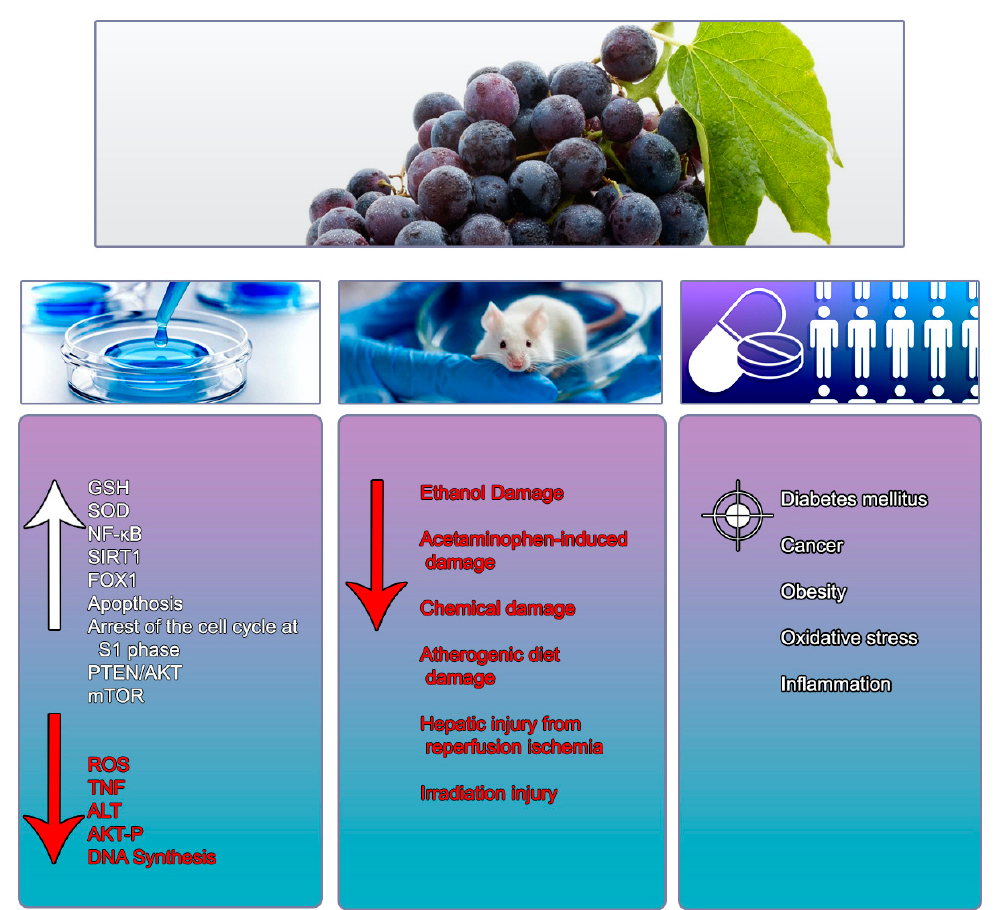
Figure 1. Summary of the main molecular mechanisms and physiological effects exerted by Resveratrol in vitro, in vivo and clinical studies. Red arrow ( ↓ ) indicates down-regulation; white arrow ( ↑ ) indicates up-regulation. GSH: glutathione; SOD: superoxide dismutase; NF- κ B: nuclear factor kappa-light-chain-enhancer of activated B cells; SIRT1: sirtuin 1; FOX1: forkhead protein O box; S1:. Synthesis Phase; PTEN/AKT: phosphatase and tensin homolog/protein kinase B; mTOR: target of rapamycin in mammals; ROS: reactive oxygen species; TNF: tumor necrosis factor; ALT: alanine aminotransferase; AKT-P: protein kinase B.